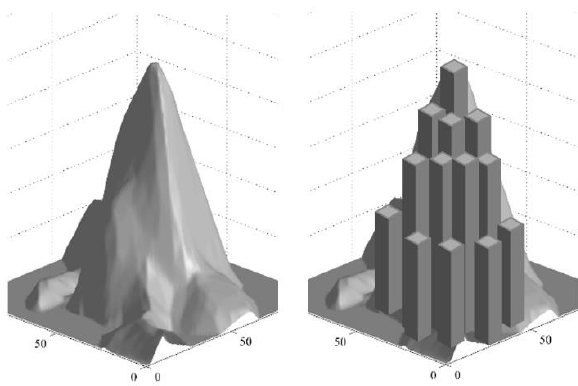
Figure 9. Calculation of the volume of an individual elevation as sum of the volumes of raster element cuboids